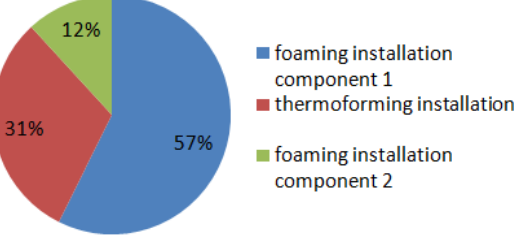
Figure 4. Energy consumption on Production Line 1.